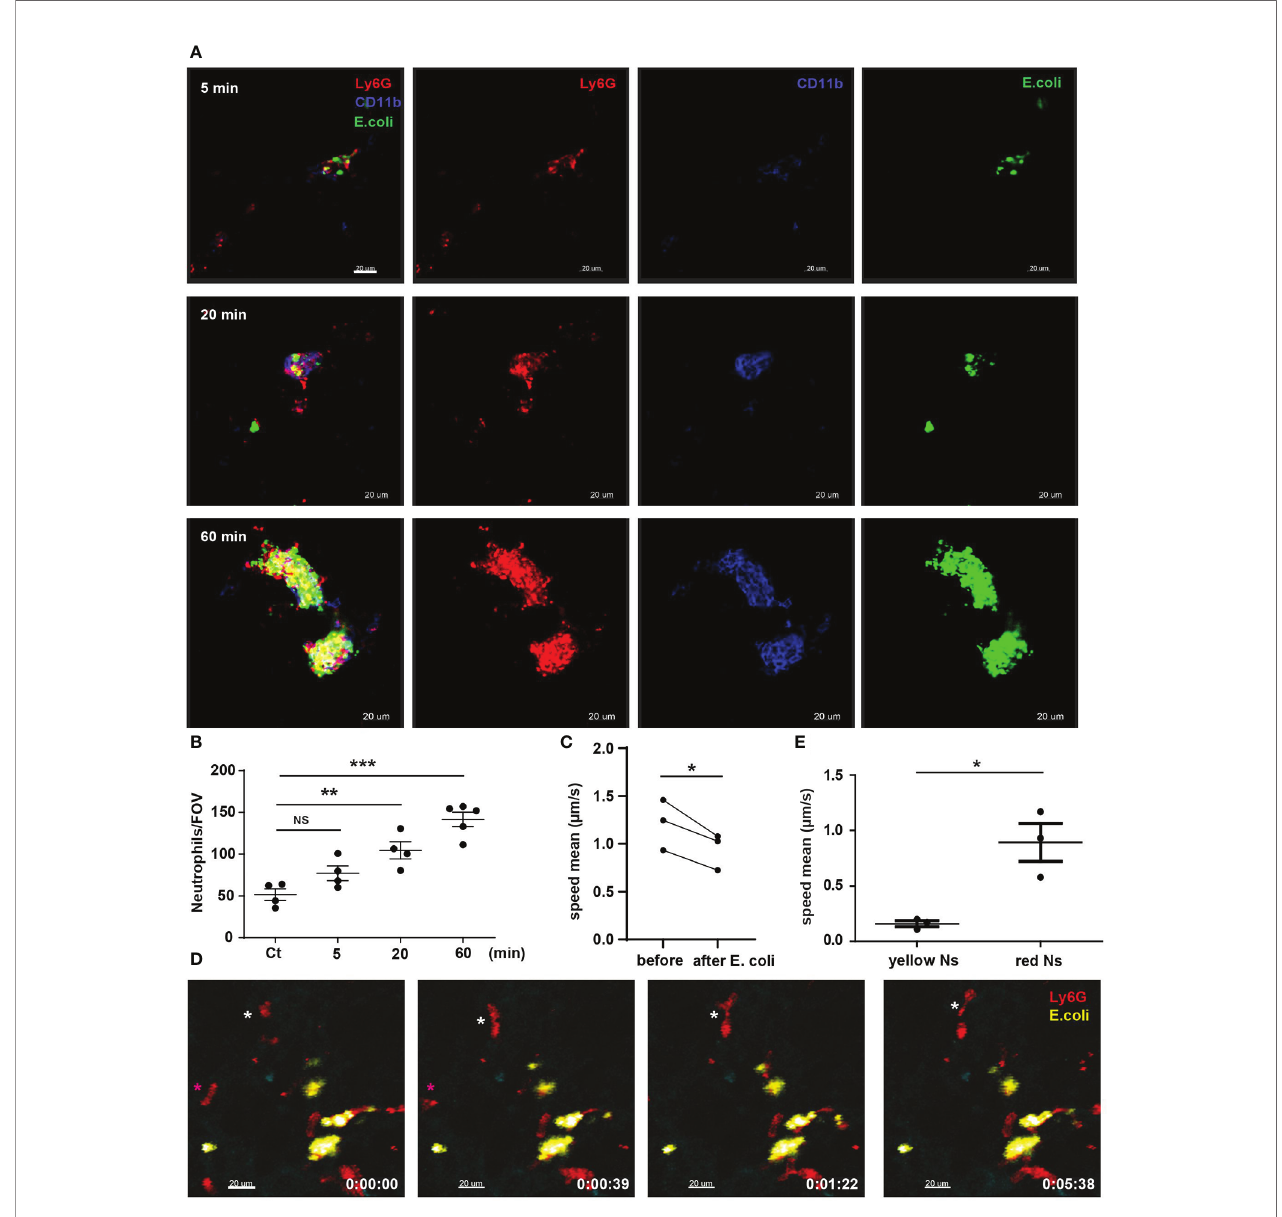
FIGURE 2 | Lung marginated neutrophils are CD11b-positive and form clusters enriched in E. coli . (A) PCLS after E. coli challenge 5, 20 and 60 min. Scale bar 20 m m. (B) Total number of neutrophils/FOV counted in PCLS after PBS (Ct) for 60 min or E. coli challenge for 5, 20 and 60 min (N=4-5 mice/timepoint), (10 FOV/ mouse), one-way ANOVA, Tukey ’ s multiple comparison test, two independent experiments. (C) L-IVM analyzed for neutrophil speed mean comparing before and 60 min after E. coli challenge (N=3 mice), paired t-test . (D) Sequential frames from video 3, E. coli -positive neutrophils (yellow Ns) are stationary, while E. coli -negative neutrophils (red Ns) are highly motile (white and magenta asterisks). Scale bar 20 m m. P < 0.05 *, P < 0.01 **, P < 0.001 ***, NS, not signi fi cant. (E) L-IVM analyzed for neutrophil speed mean comparing E. coli -positive neutrophils (yellow) and E. coli -negative neutrophils (red) 60 min after E. coli challenge (N=3 mice), t-test